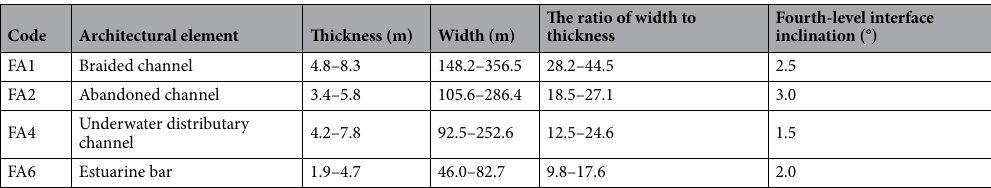
Table 5. Geometric parameters of the four main skeletal architectural